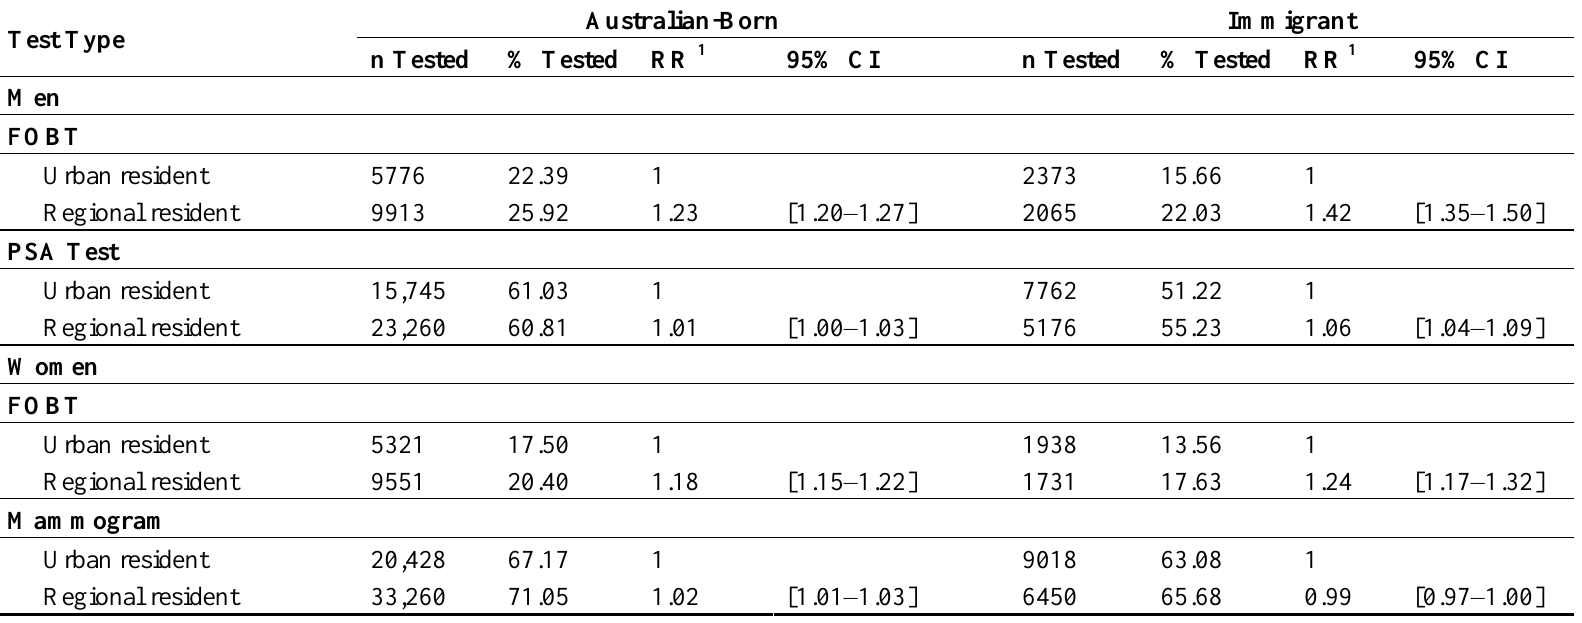
Table 2. Relative risks (RR) and 95% confidence intervals of faecal occult blood test (FOBT), and prostate specific antigen (PSA) test, and mammography use, in the last two years among immigrants and Australian-born participants by place of residence, in the 45 and Up Study